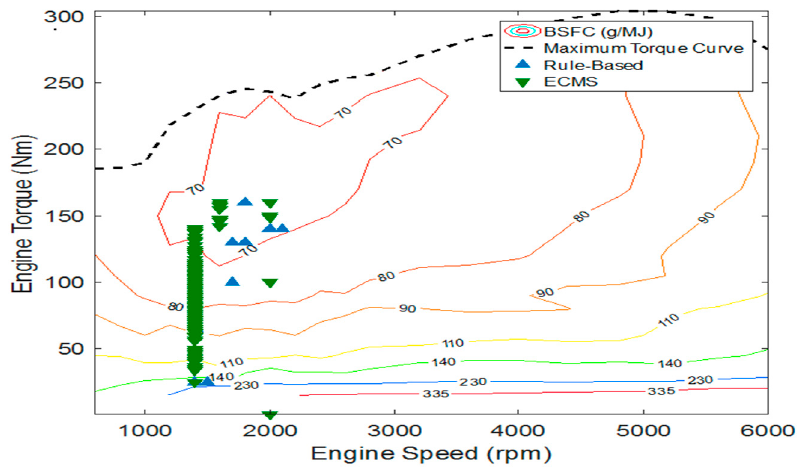
Figure 12. Comparison of engine operating points when driving on expressway.